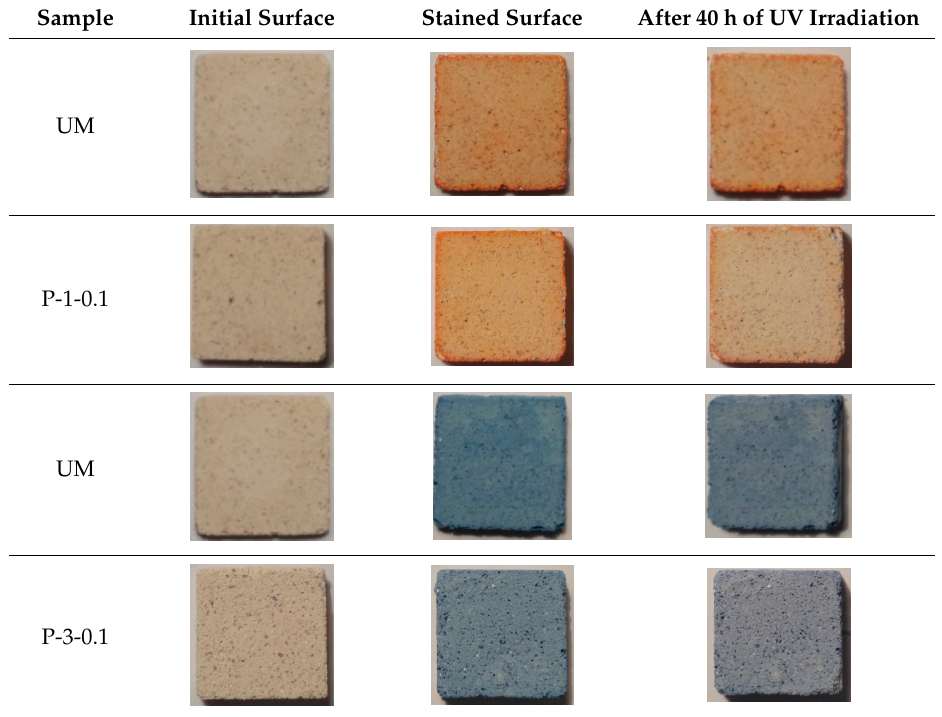
Table 3. Images of exemplary gypsum plates during the photocatalytic experiments.